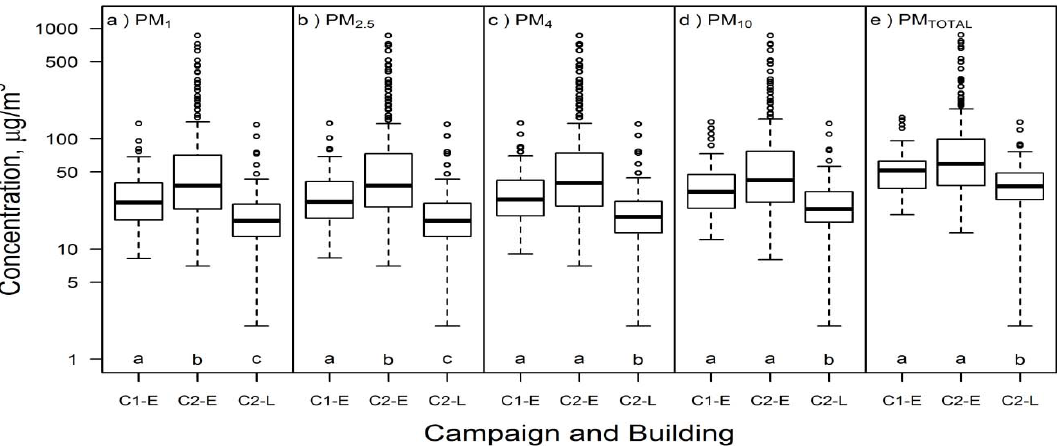
Figure 1. Airborne particulate mass concentration ( μ g/m 3 ) in Campaign 1 Building E (C1 ‐ E; n = 55), Campaign 2 Building E (C2 ‐ E; n = 168), and Campaign 2 Building L (C2 ‐ L; n = 116) for ( a ) PM 1 ; ( b ) PM 2.5 ; ( c ) PM 4 ; ( d ) PM 10 ; and ( e ) PM TOTAL . Different letters within the same box represent statistically significant ( p < 0.05) groups under the Kruskal ‐ Wallis multiple comparisons test.